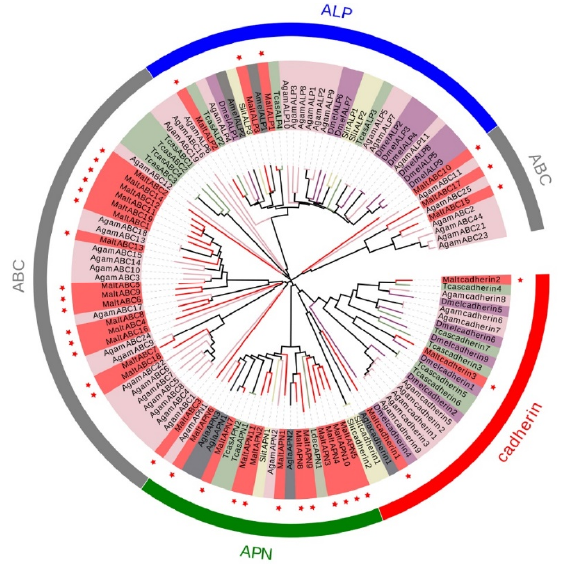
Figure 3. Phylogenetic analysis of Bt receptor genes. M. alternatus (Malt), A. glabripennis (Agla), T. castaneum (Tcas), A. gambiae (Agam), S. litura (Slit), and D. melanogaster (Dmel) Bt receptors were included in the analysis. Bt receptors from different species are indicated by different colors. Bt receptors genes of M. alternatus are marked with red stars.